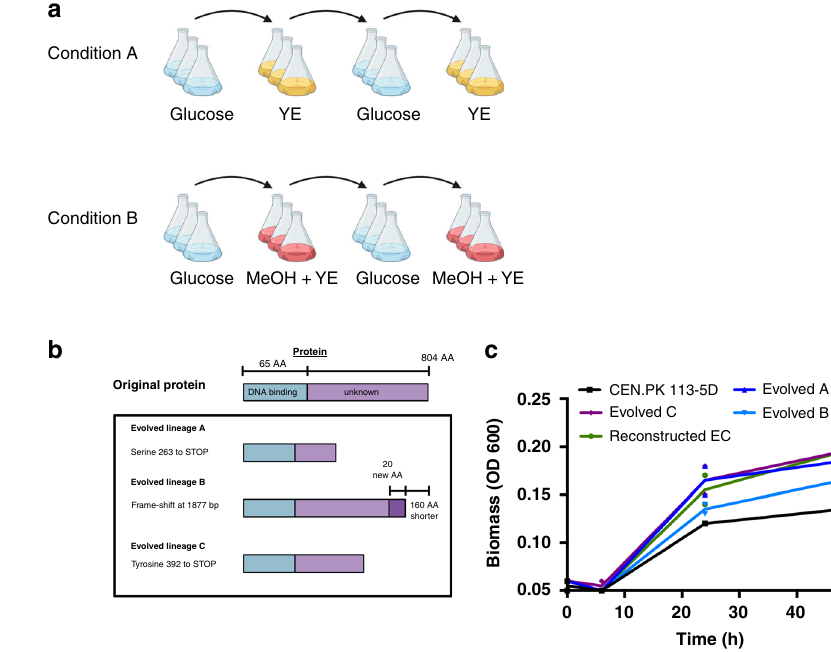
Fig. 2 Adaptive laboratory evolution to improve native methanol assimilation in CEN.PK 113-5D. a Schematic of the ALE design. Three independent lineages of CEN.PK 113-5D (with pRS416) were grown in baf fl ed shake fl asks in condition A or B for 230 generations. Under condition A, cultures were passaged from YNB medium without amino acids and 1% glucose (24 h) to YNB medium without amino acids and 0.1% yeast extract (YE) (48 h). Under condition B, cultures were passaged from YNB medium without amino acids and 1% glucose to YNB medium without amino acids, 2% methanol and 0.1% yeast extract (MeOH + YE) (48 h). Figure was created with BioRender.com. b Schematic of the mutations in YGR067C from the three evolved lineages grown under condition B, and the changes they caused to the protein, all three mutations theoretically led to truncations. c Growth pro fi les of CEN.PK 113- 5D (black squares), the three evolved lineages (A, dark blue upright triangles. B, light blue inverted triangles. C, purple diamonds.) in condition B, and the reconstructed CEN.PK 113-5D strain with the mutation observed in the evolved lineage C (green circles). Strains were grown in liquid YNB medium with 0.1% yeast extract and 2% methanol. Data are from two independent biological replicates with lines representing the mean. Source data are provided as a Source Data fi